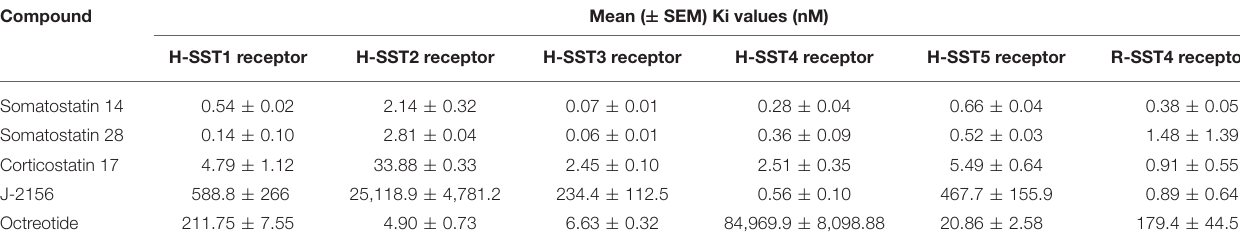
TABLE 1 | Selectivity of somatostatin agonists at human somatostatin receptor types 1–5 and the rat somatostatin receptor type 4. Compound